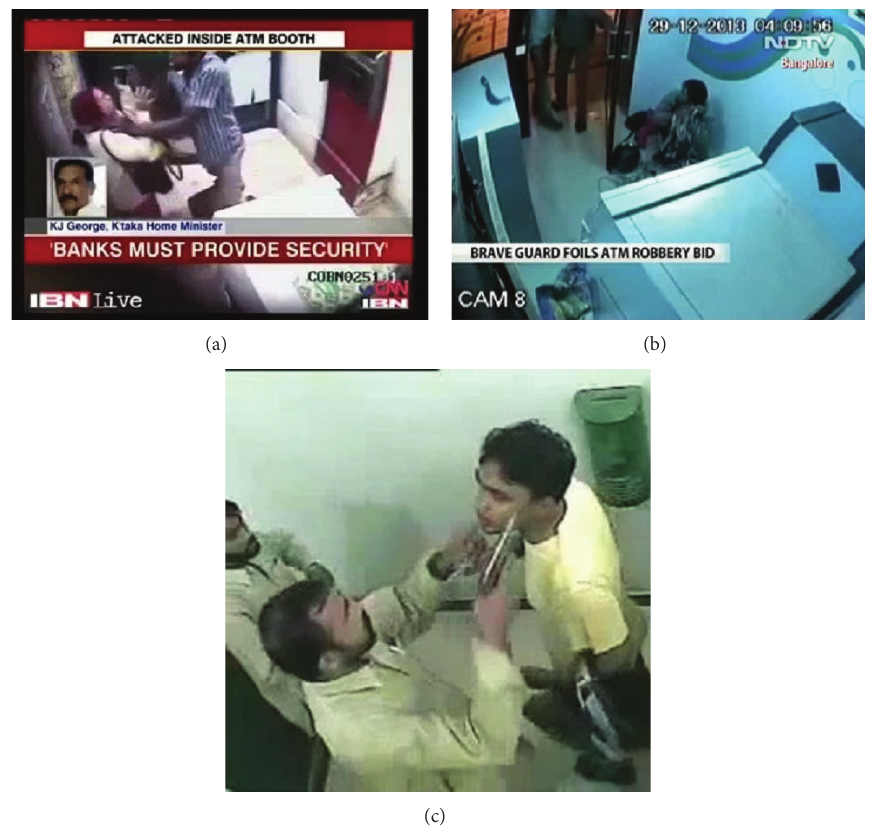
Figure 1: Attack on person at various ATM